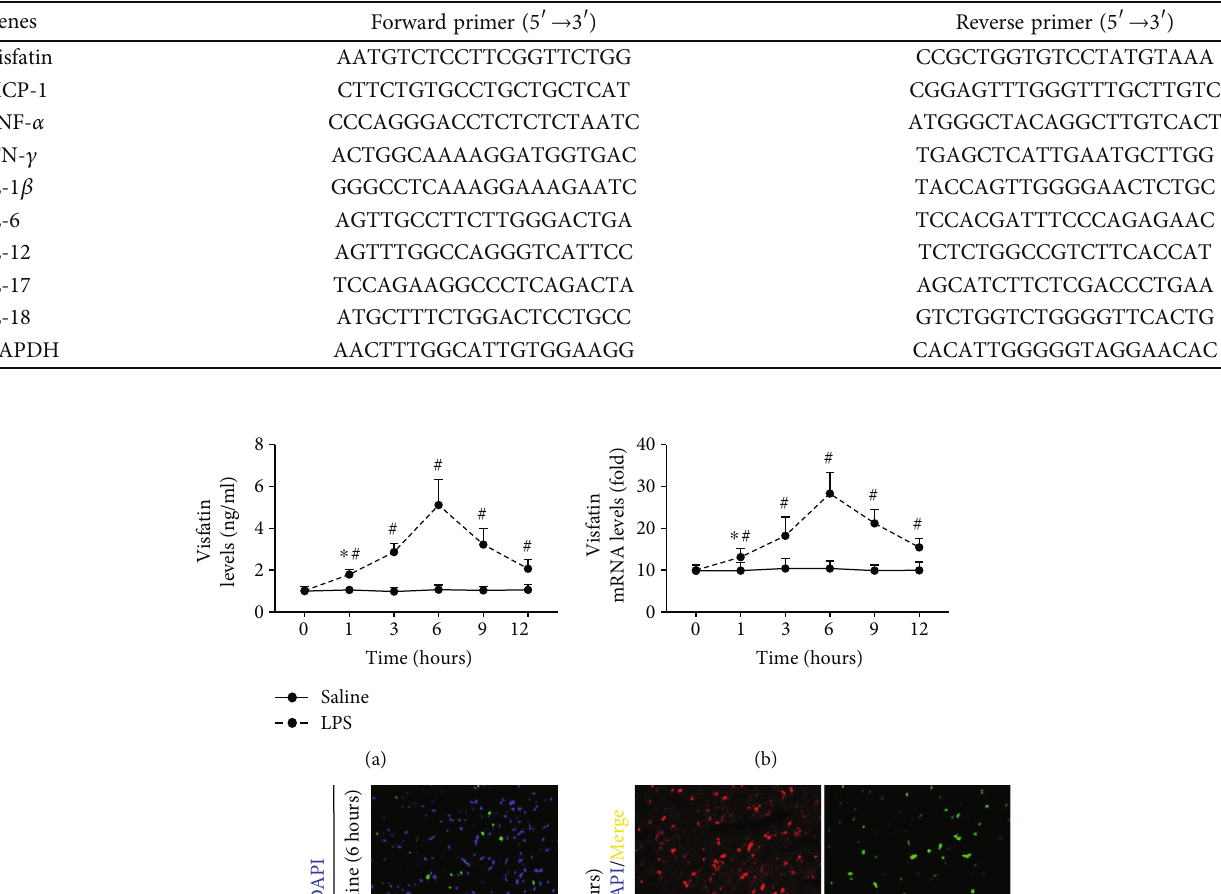
Table 1: Primers used in this study.